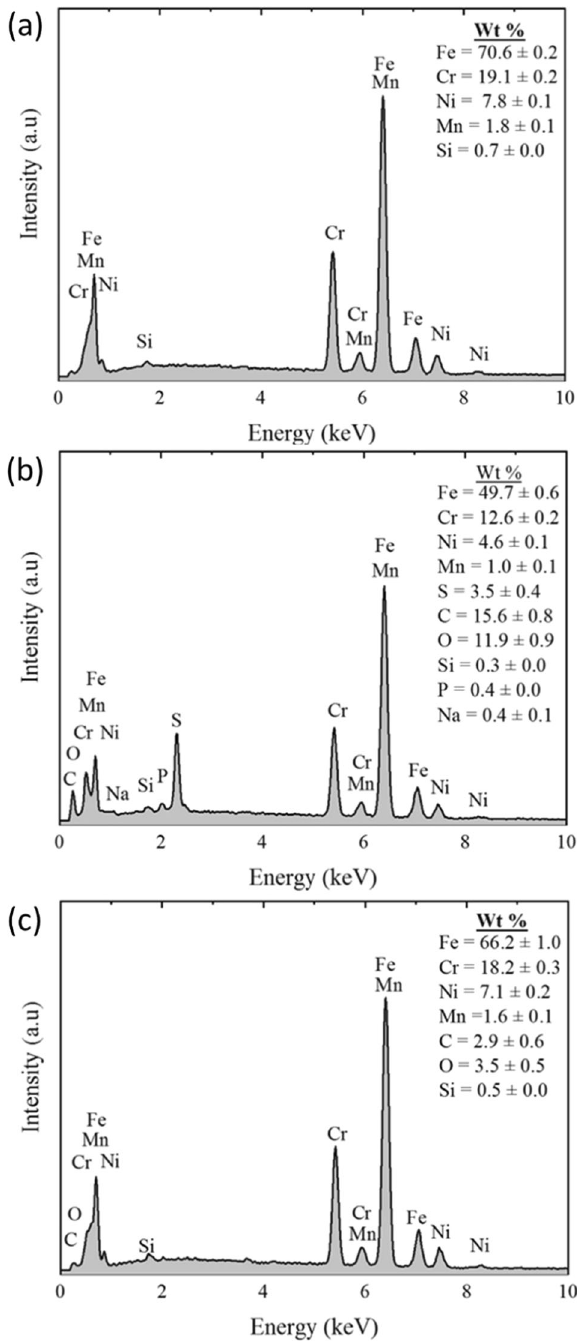
Fig. 5 EDS spectra showing elemental composition of bio fi lm/ corrosion products. EDS spectra of ( a ) freshly polished 304 stainless steel coupon; and ( b, c ) bio fi lm/corrosion products formed on the surface of 304 stainless steel coupons after 32 days of immersion in ( b ) MB, and ( c ) MBN test media inoculated with SRB. Data shown inset: Mean ± SE.